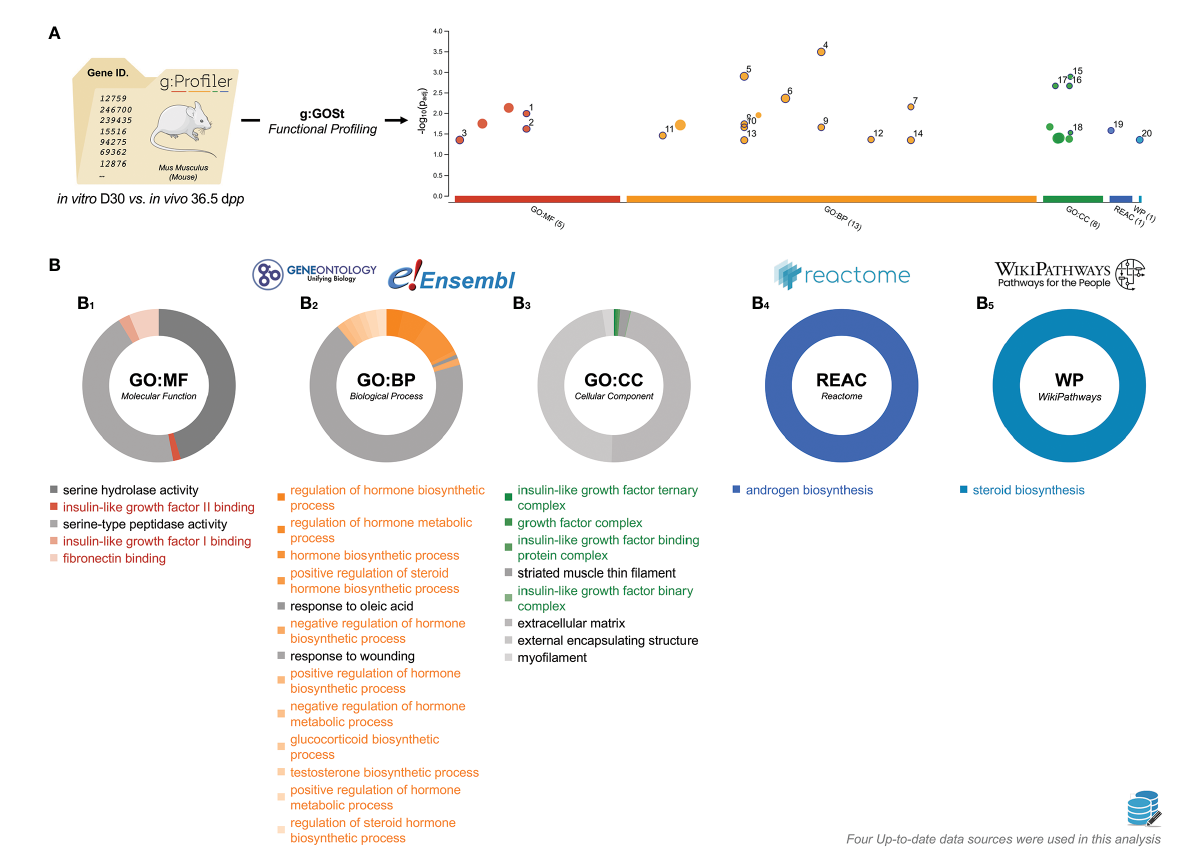
to two principal biological mechanisms: (i) insulin-like growth factor (IGF) binding (molecular function, Figure 8B 1 ) and IGF complex (cellular component, Figure 8B 3 ) and (ii) hormones and steroids (biological process, Figure 8B 2 ), androgen biosynthesis (reactome, Figure 8B 4 ), and steroid biosynthesis (wikipathways, Figure 8B 5 ).